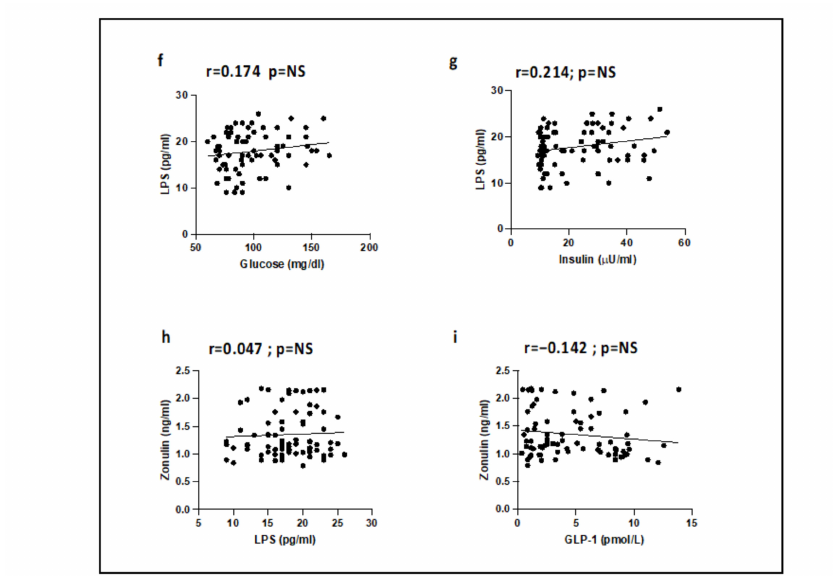
Figure 2. Serum levels of ( a ) glucose, ( b ) insulin, ( c ) GLP-1, ( d ) LPS, and ( e ) zonulin before (T0) and 2 h after a meal with (black line) or without (grey line) extra-virgin olive oil (EVOO) in HS ( n = 20). Correlations of circulating LPS levels with ( f ) glucose, ( g ) insulin, and ( h ) zonulin in HS. Correlations of circulating Zonulin levels with ( i ) GLP-1 in HS. ** p < 0.001.